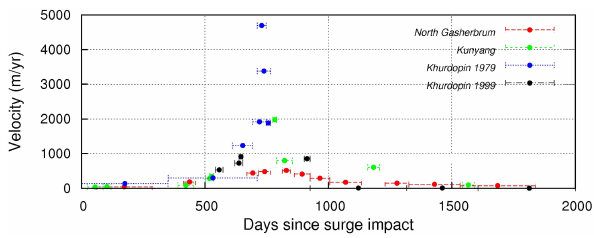
Fig. 2. Centreline surface velocities extracted from feature tracking data before, during and after the surge of 1979. Fig. 3. Surge propagation through a point ∼ 5km up-glacier from the terminus. Note that the shape of the 1979 surge evolution is similar to those events previously plotted by Quincey et al. (2011) (North Gasherbrum, Kunyang, Khurdopin 1999), but the magnitude of the maximum measured velocity is >2 times